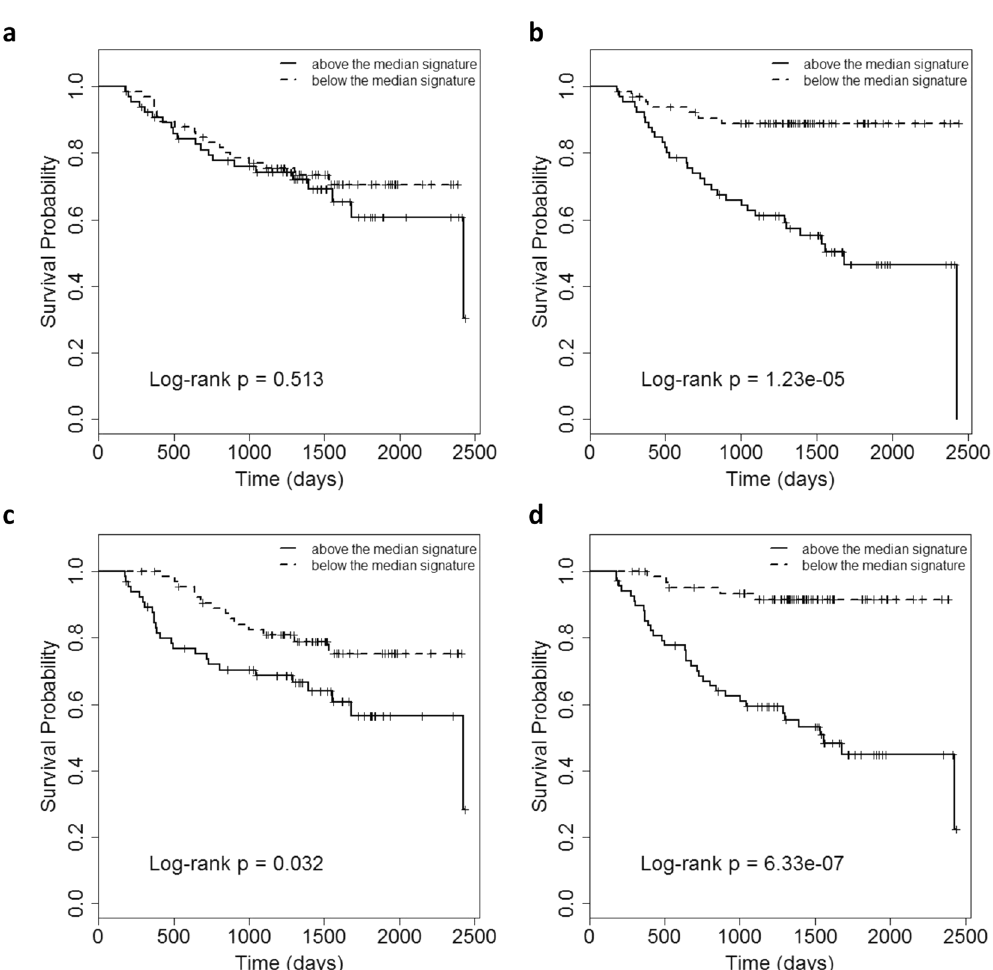
Figure 4. Kaplan Meier plots of RFS in cross-validated datasets showing the performance of selected ( a ) aggregate, ( b ) voxel-wise and ( c ) baseline and ( d ) baseline plus voxel-wise features. The voxel-wise model indicated a high performance (log-rank p < 0.001), while the aggregate features were unable to separate high- risk from low-risk patients (log-rank p = 0.513). Also, the selected voxel-wise features in combination with the baseline features could improve the baseline model significantly ( p < 0.05).